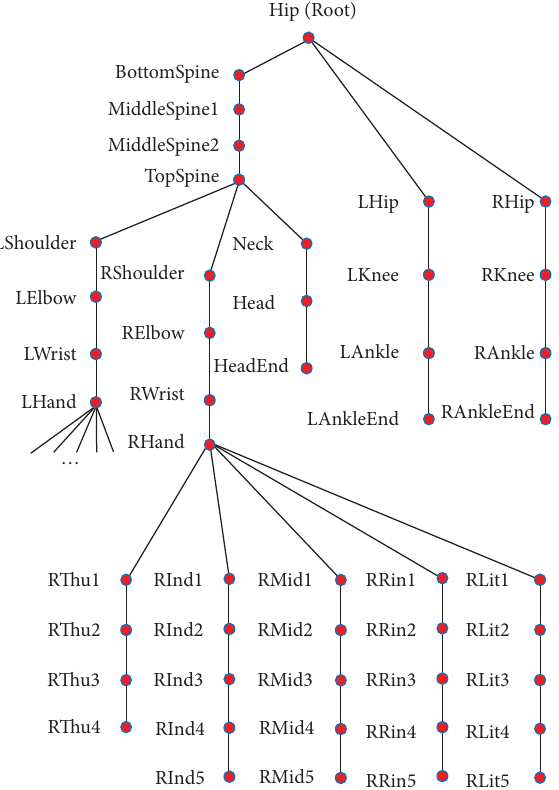
Figure 3: Te node tree of the human skeleton